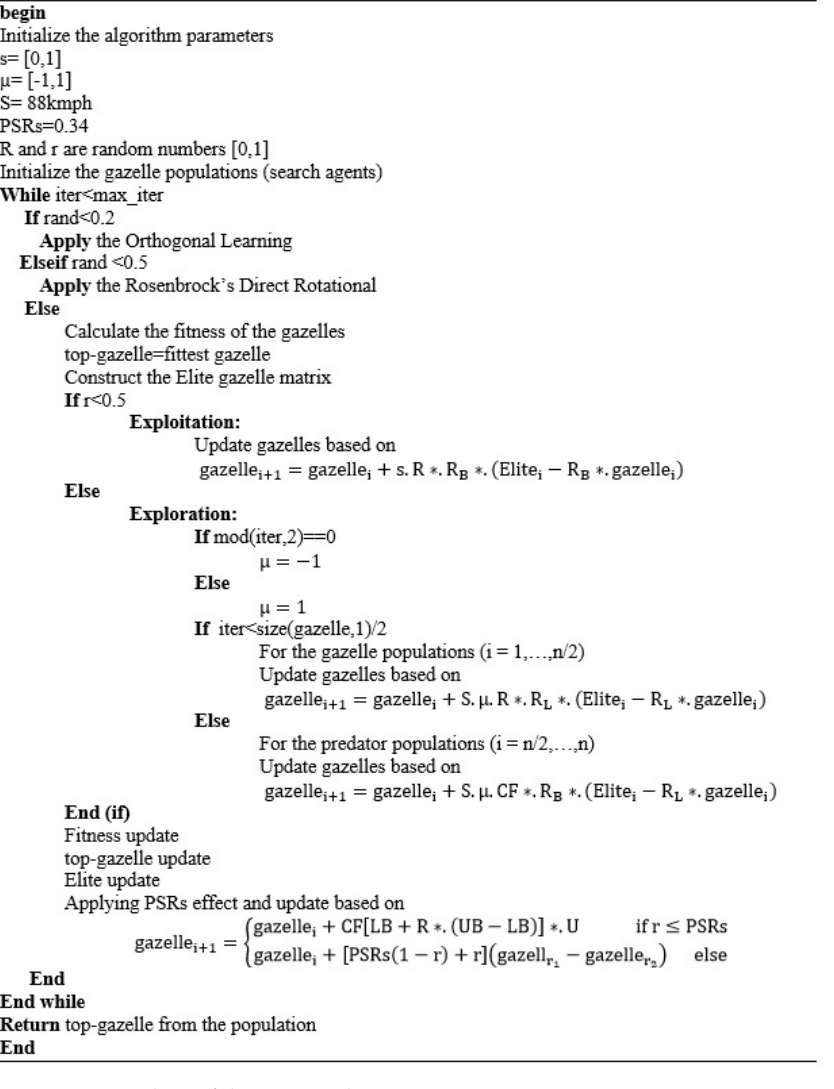
Figure 4. Procedure of the proposed